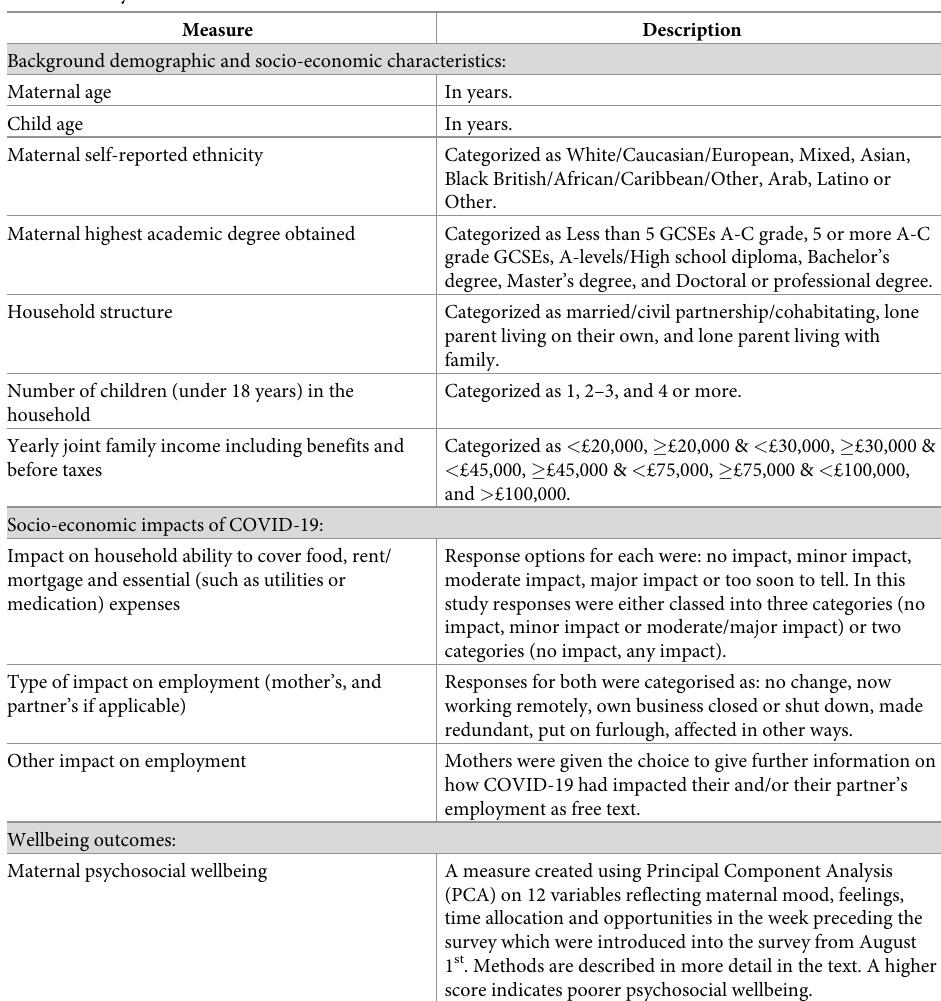
Table 1. Study measures. Measure